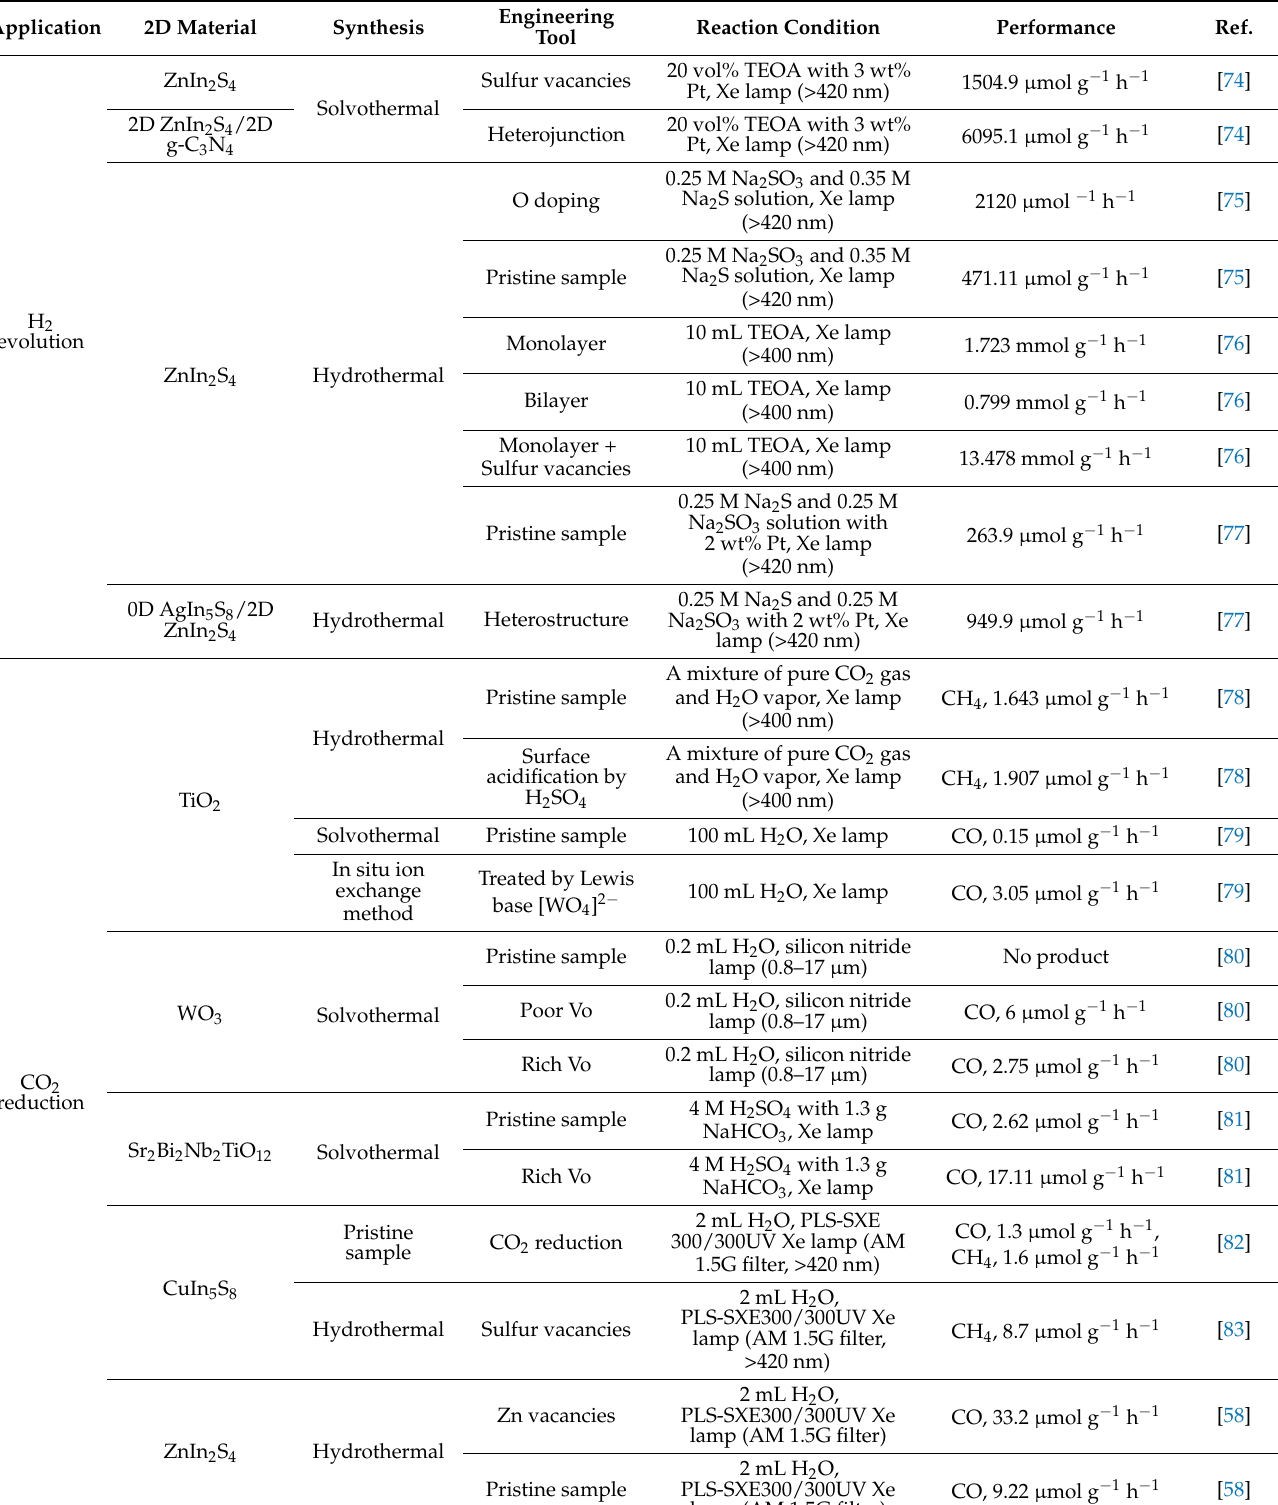
Table 1. Various 2D MOs for environmental remediation with adopted strategies for enhancing the